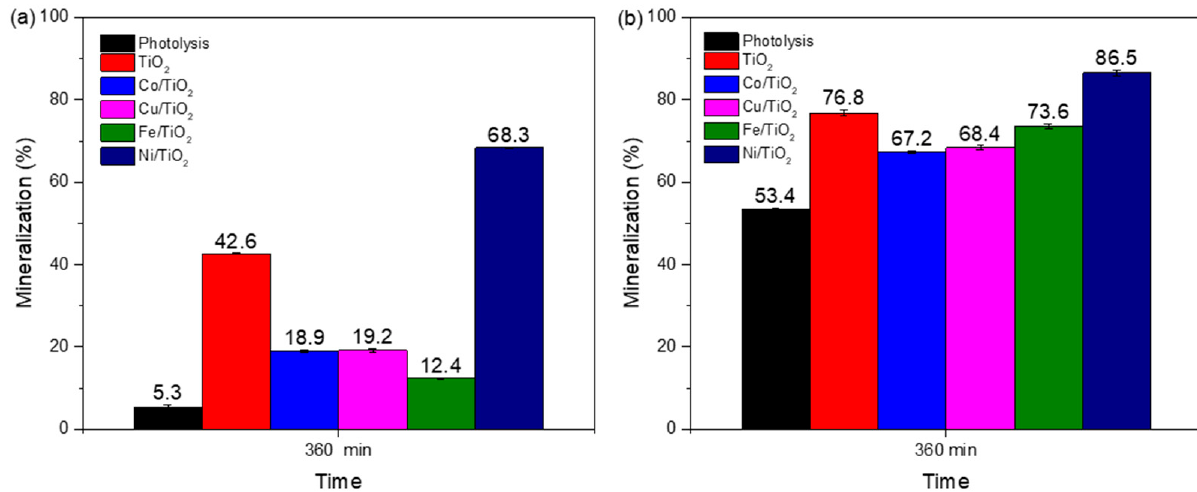
Figure 15. Removal of total organic carbon (TOC): 2,4-D ( a ) and 2,4-DCP ( b ). Table 5. Mineralization (%) TOC for 2,4-D and 2,4-DCP. Compound